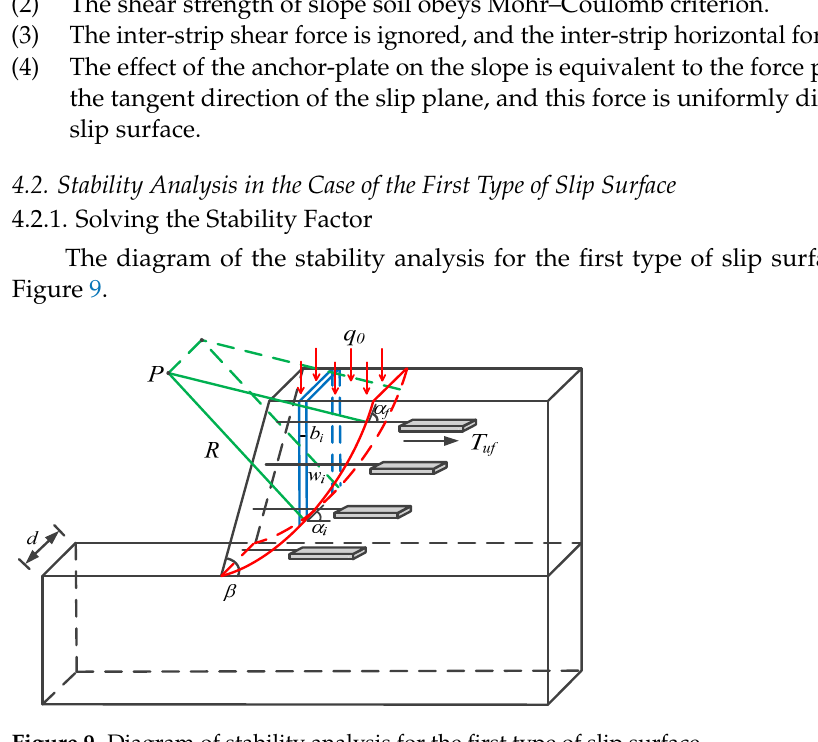
Figure 9. Diagram of stability analysis for the first type of slip surface.